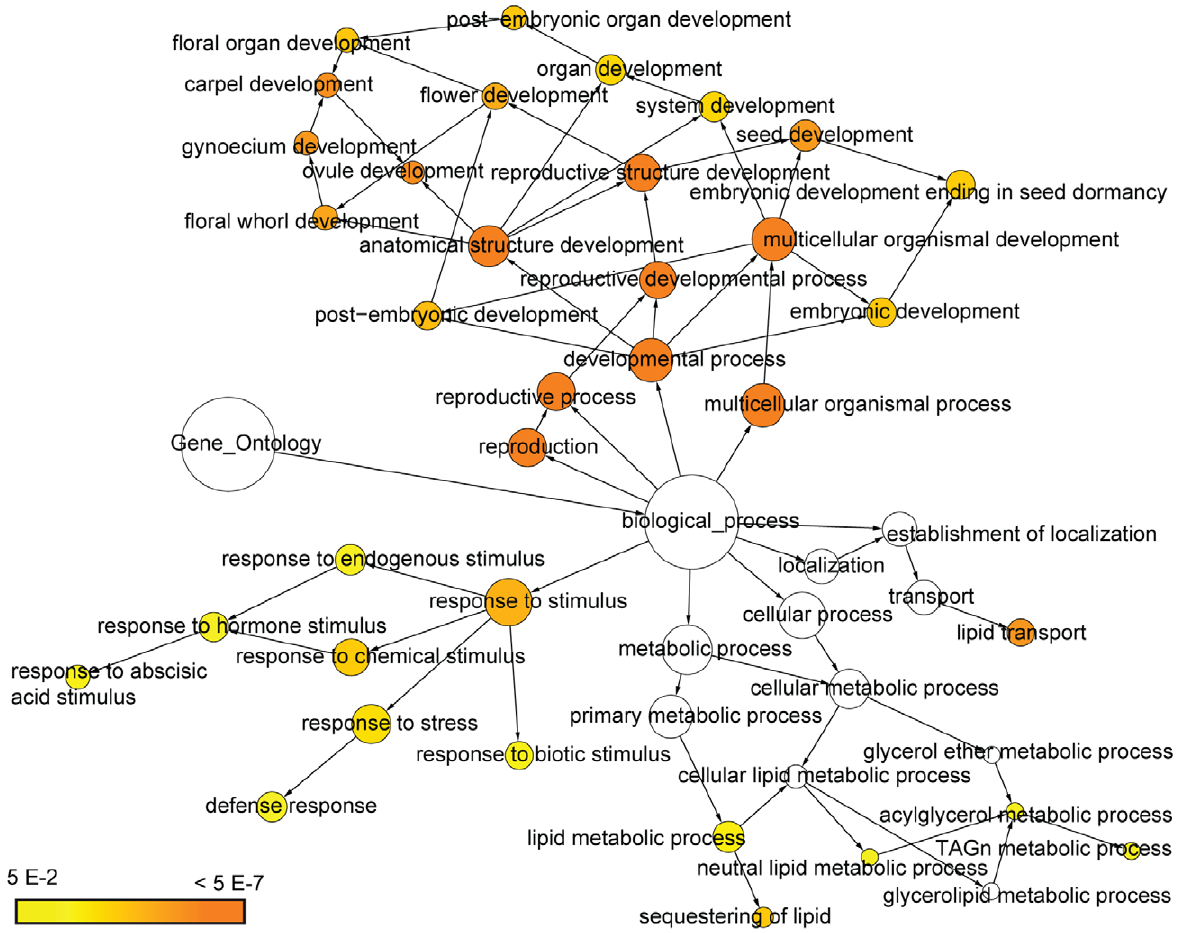
Figure 4. Overrepresented gene ontology categories in the set of H3K27me3 targets that are up-regulated in fie . BiNGO (the Biological Network Gene Ontology tool) analysis representing over-represented categories of the ontology Biological Process among the genes that are marked by H3K27me3 in the wild type (20 DAS) and are significantly up-regulated in 7 DAS fie mutant seedlings. The size of the nodes is proportional to the number of genes in the test set which are annotated to that node. Colored nodes are significantly over-represented, with a color scale ranging from yellow (p-value=0.05) to dark orange (p-value=5.00 E -7). Statistical testing was as described by Maere et al. (2005) [31].